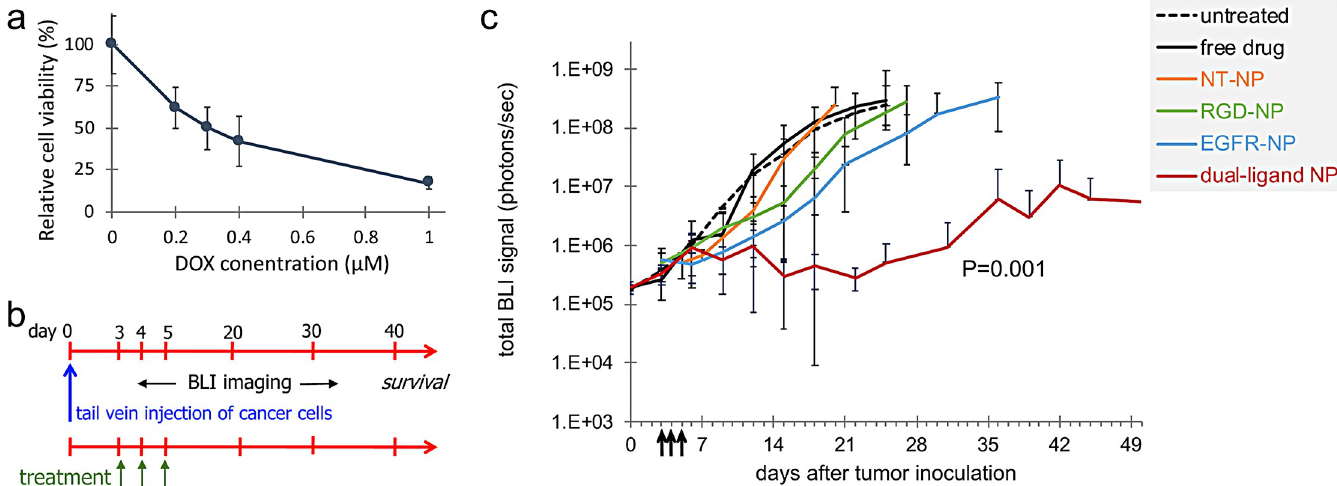
Fig 3. Treatment of mice with D2.A1 metastasis using dual-ligand nanoparticle loaded with doxorubicin. (a) The cytotoxicity of doxorubicin (DOX) was evaluated on D2.A1 cells. Cytotoxicity studies were performed by seeding D2.A1 cells at a density of 5 x 10 3 cells per well. Cells were incubated with the treatment for 24 h at a concentration ranging between 0.2–1 μ M DOX. After treatment application, the cells were washed three times with fresh medium and then incubated for 48 h at 37˚C. The number of viable cells was determined using a formazan-based cell counting assay (CCK-8). Untreated cells served as live controls for normalization of the data. Data points represent group mean ± s.d. (b) The timeline and schedule of treatments are shown with respect to tumor inoculation. (c) The response of cancer metastasis to treatment was monitored using longitudinal BLI imaging. Quantification of the BLI signal in the thoracic region is shown for mice with D2.A1 metastasis treated at days 3, 4 and 5. In addition to untreated animals, treatments included non-targeted NP (NT-NP), RGD-NP, EGFR-NP, dual-ligand NP, and free DOX (n = 6–8 mice per treatment). The y-axis is in logarithmic scale. All nanoparticle formulations were administered at 7.5 mg/kg DOX (two-way ANOVA with repeated measures).